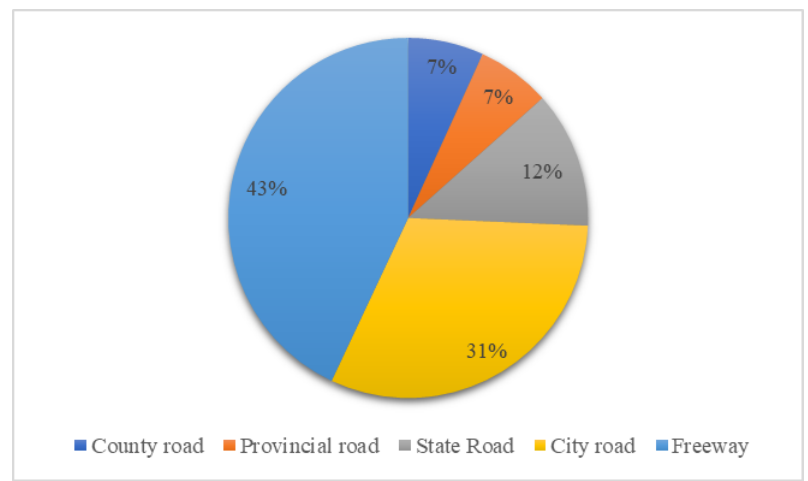
Figure 4. The distribution of Hazmat transportation accidents by road types.